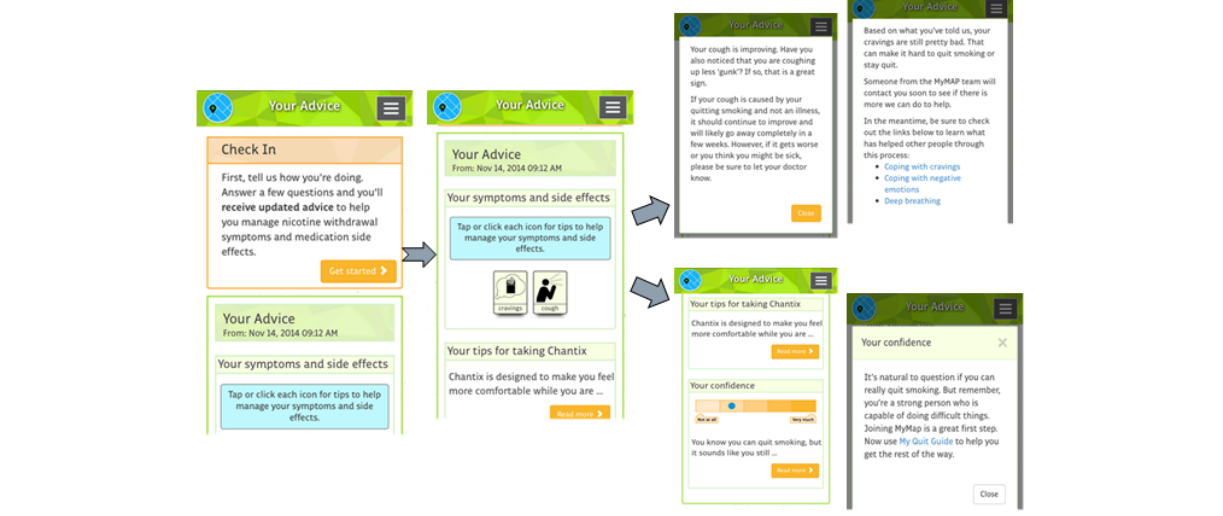
Figure 3. MyMAP tailored